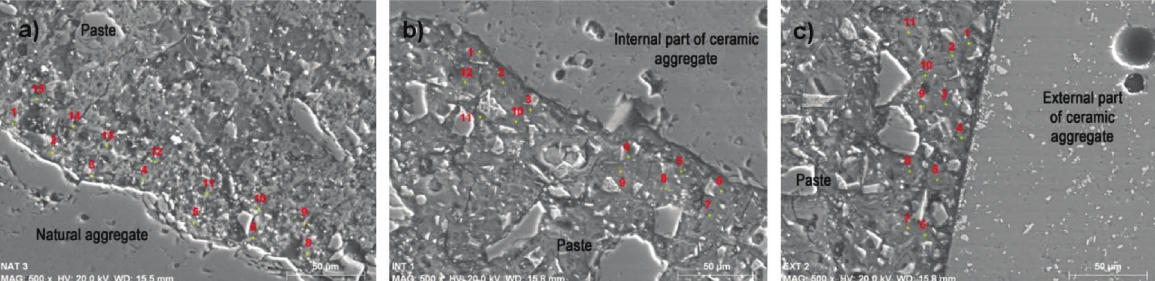
Fig. 7. BSE image of different ITZs (500X): a) Aggregate/paste; b) Internal part of ceramic aggregate/paste; c) External part of ceramic Table 5. Elastic modulus (GPa) vs distance from the aggregate surface by type of aggregate Elastic modulus (GPa) Distance from the interface (μm) Gravel Internal part (matrix)